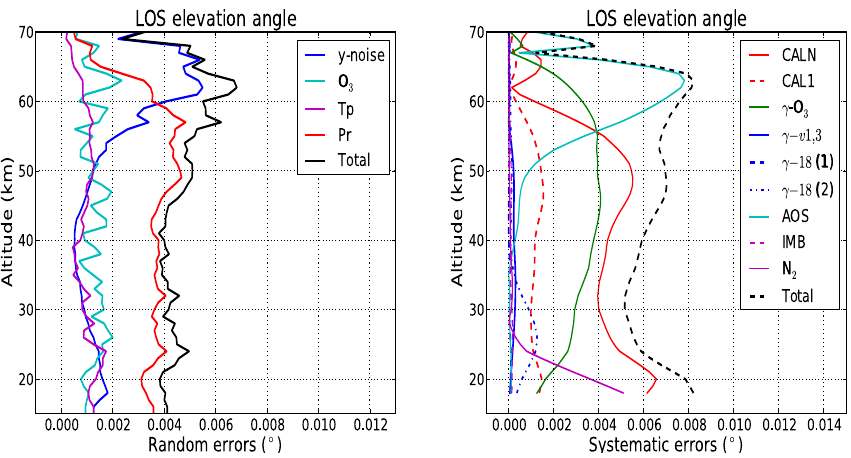
Fig. 7. Assessment of errors on the retrieved line-of-sight elevation angles from window A/B-w0. The random and systematic errors are shown in the left and right panels, respectively. The meaning of the labels and the assumed errors on the parameters are given in Table 5. The black line is the total error calculated as the root-sum-square of all sources of error.